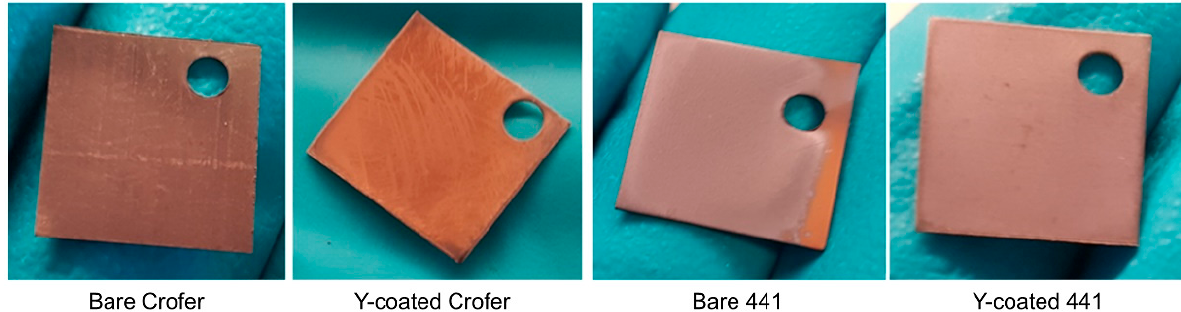
Figure 5. Pictures of the samples after aging in H 2 -H 2 O atmosphere at 800 °C.